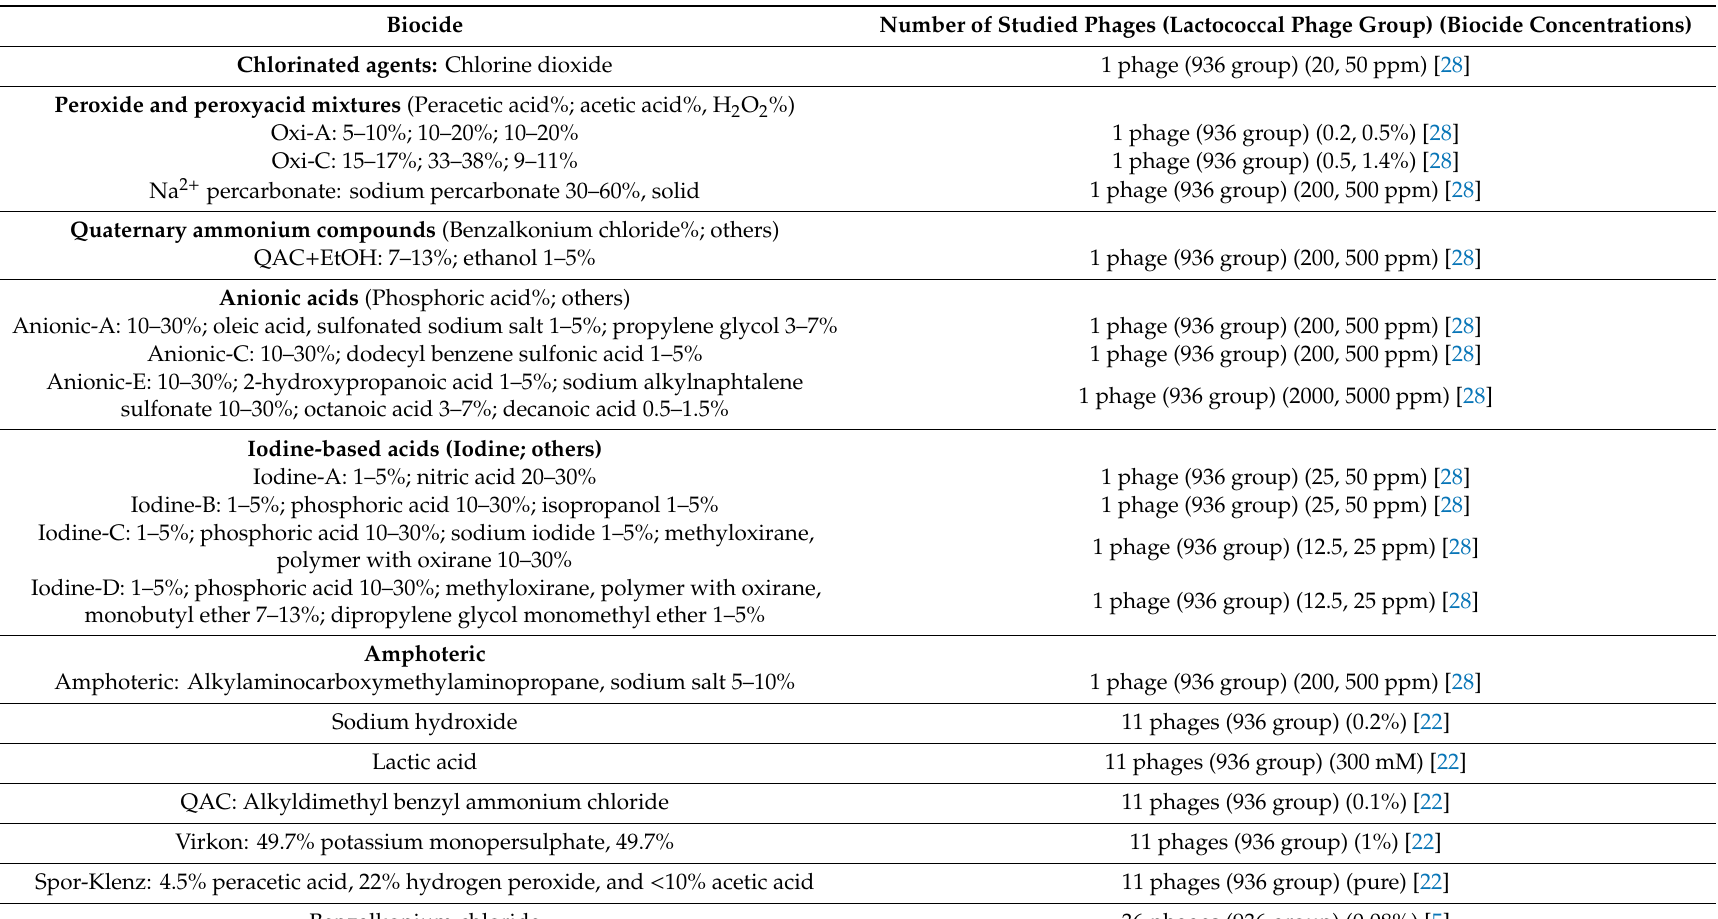
Table 3. Biocides studied for inactivation of lactococcal